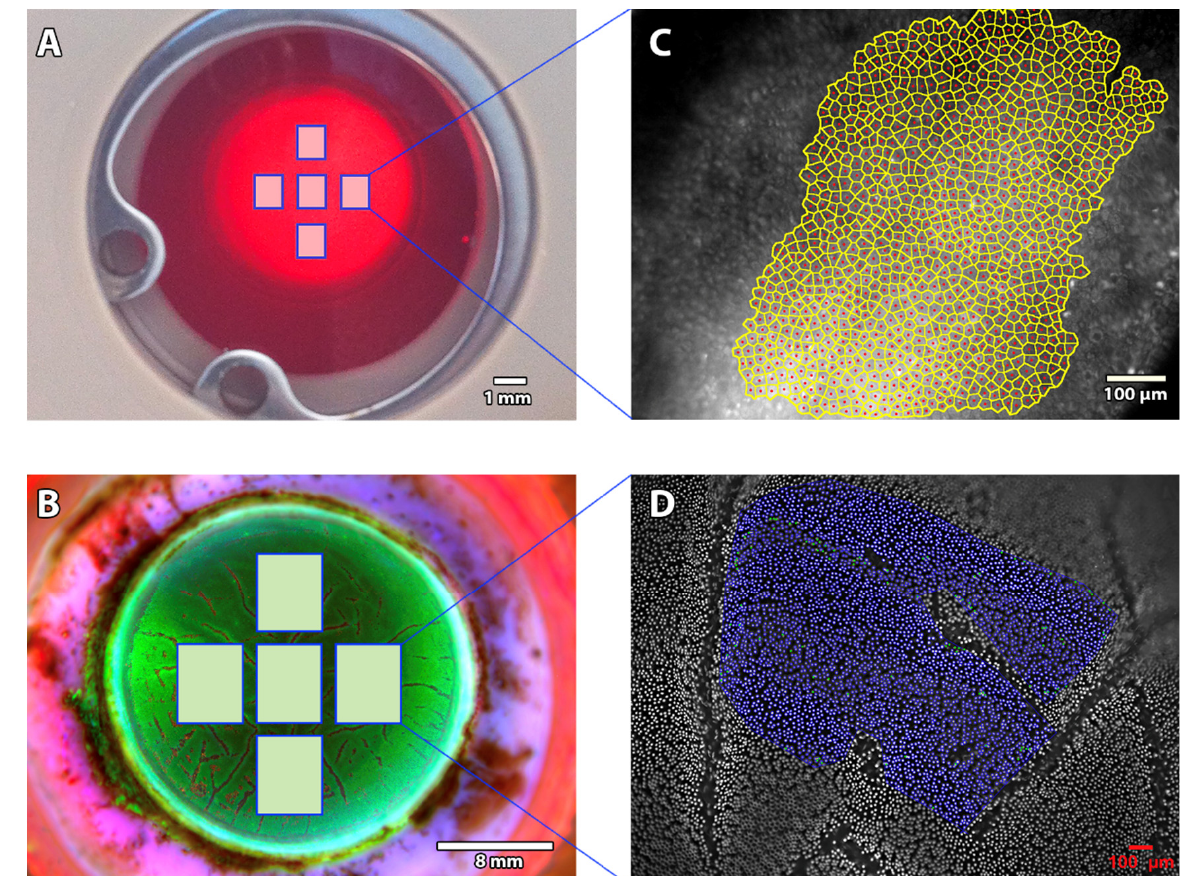
Figure 3. Image acquisition methods. ( A ) Five non-overlapping fields were captured with our non-contact specular microscope. ( B ) Pancorneal triple Hoechst-Etidium-Calcein staining. Five non-overlapping fields were analyzed. In the present study, we used the Hoechst staining image (100% visible nuclei) as a gold standard to analyze the accuracy of specular count. ( C ) Each field was analyzed with validated variable-frame center method [12,13]. ( D ) A close-up view of one of the fields, nuclei of the endothelial cells were counted thanks to the CorneaJ plugin [10,11].